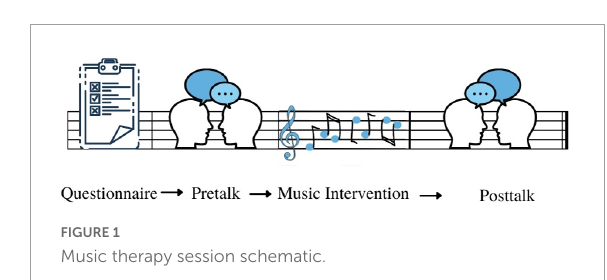
FIGURE1 Music therapy session schematic.